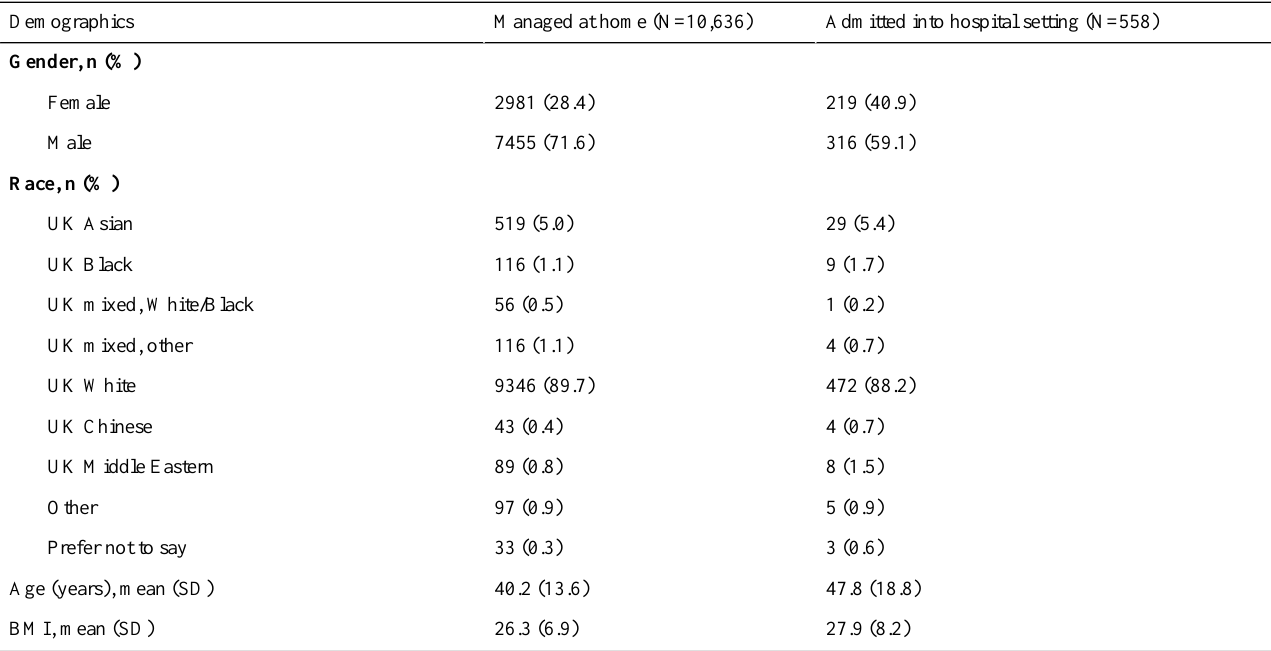
Table 3. Features of demographics investigated in relation to whether a user was seeking treatment. Age and BMI were continuous features, while race and gender were categorical.